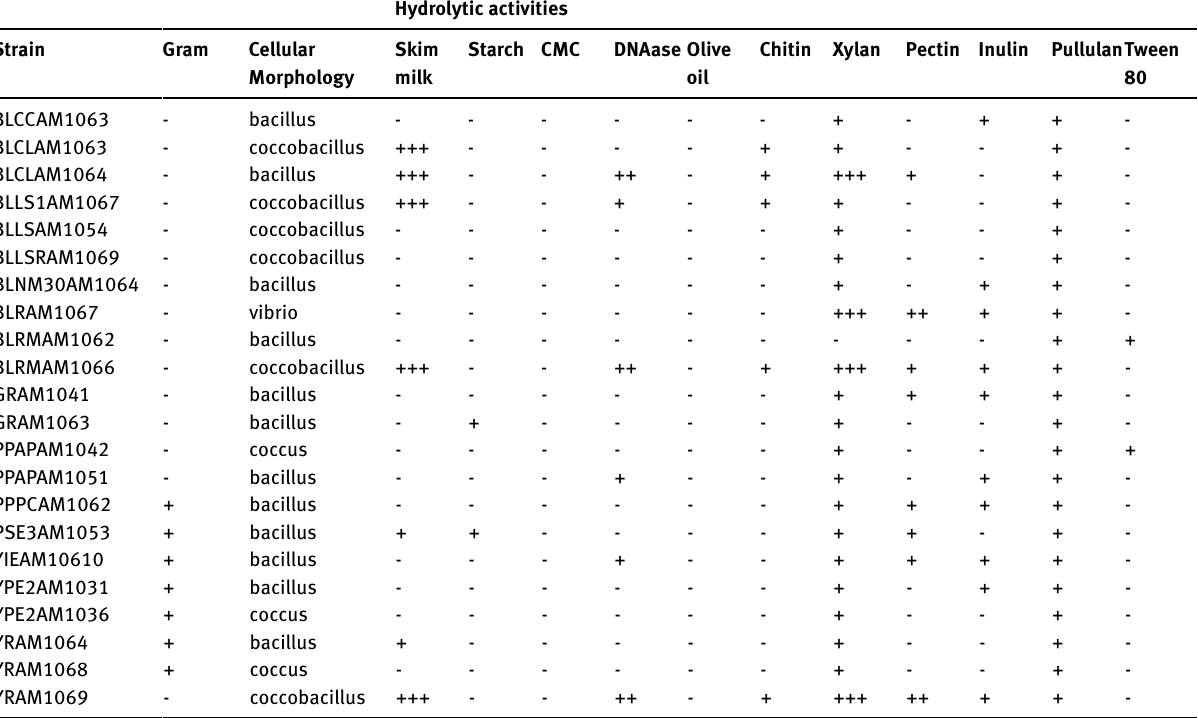
Table 1: Cellular morphology and hydrolytic activity of moderately halophilic strains from Bahía de Lobos, Yavaros, Guaymas and Puerto Peñasco